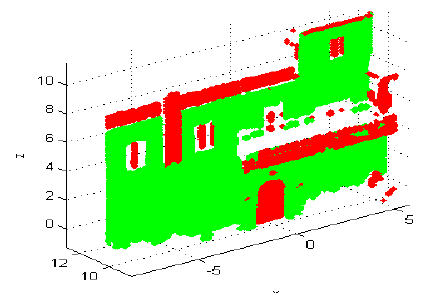
Figure 5. Recognition of main planes with ds = 0.06 m: main primary plane is the green part while the red part refers to outliers segmented into two other primary planes.